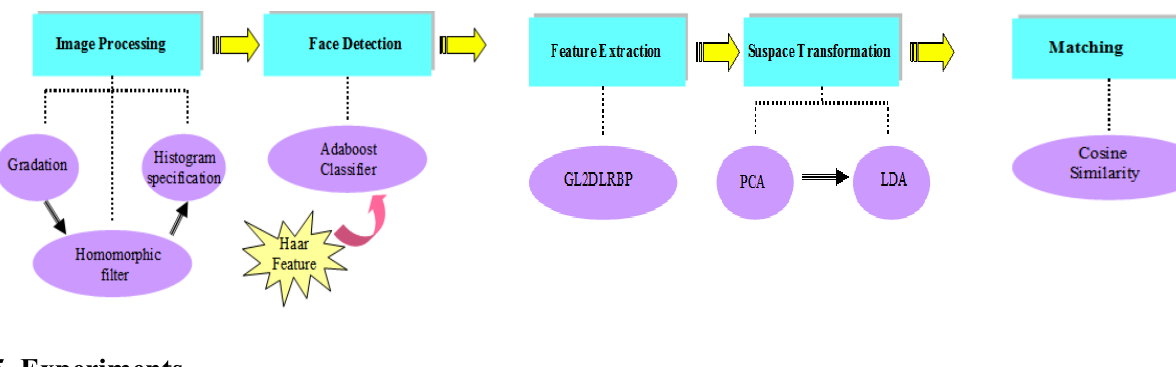
Figure 6. The recognition system of our